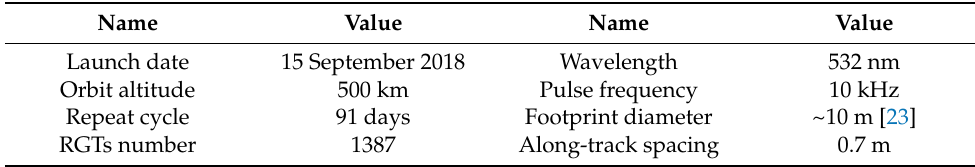
Table 1. Detailed information of